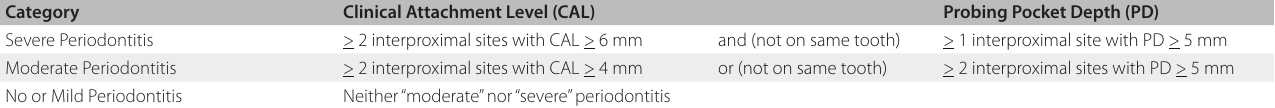
Table 1. Clinical case definitions proposed by the CDC Working Group for Use in Population-Based Surveillance of Periodontitis 27